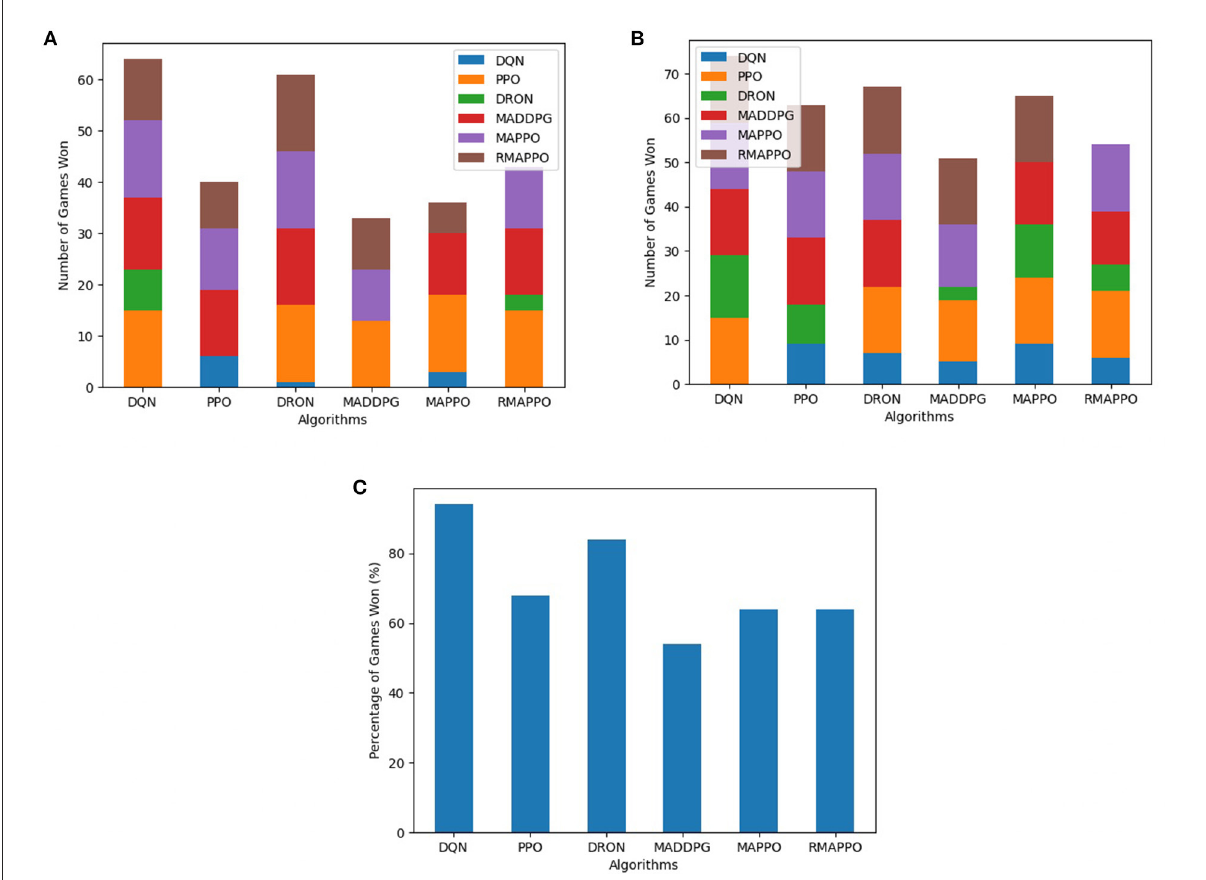
FIGURE3 Performance of various algorithms when playing against other algorithms in the Boxing environment. (A) Shows the number of games won as the first player, (B) shows the number of games won as the second player, (C) shows the overall win rate